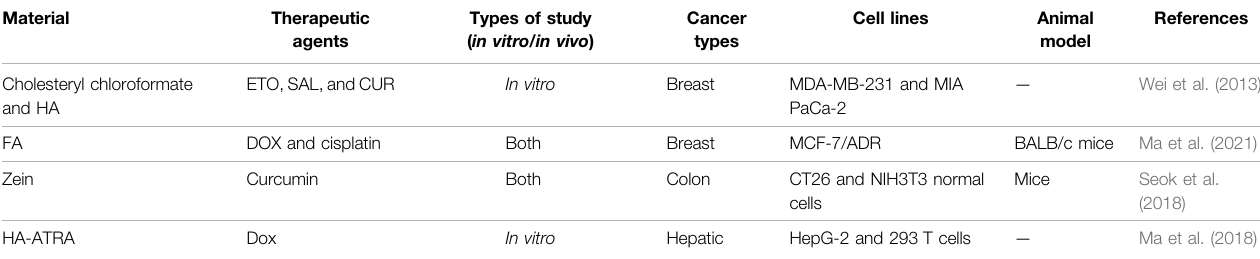
TABLE 8 | Outline of CD44-targeted therapy using nanogels.